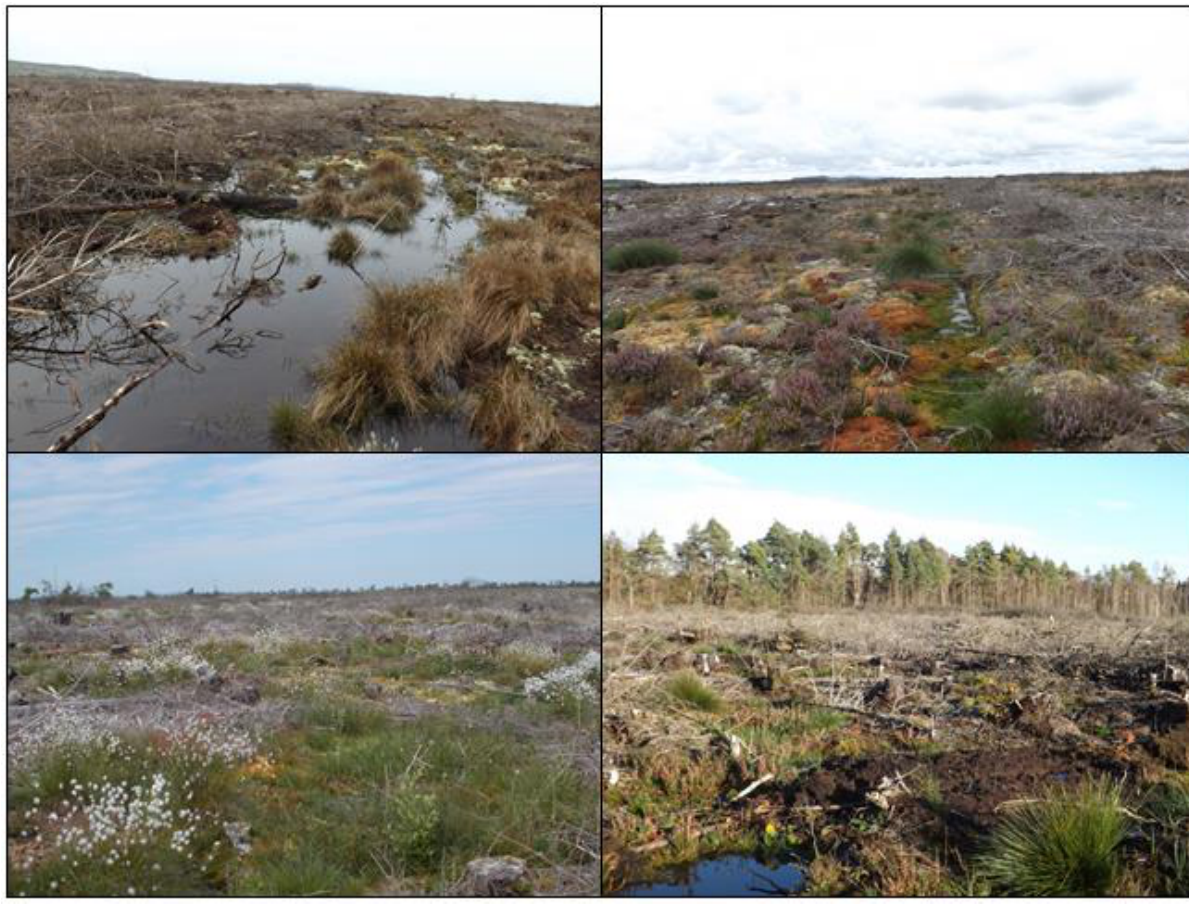
Figure 2. The Scohaboy site at different times during the two years of the study. Clockwise from top left: March 2014, August 2014, November 2015 and June 2015. Table 1. Plant species recorded in the study plots, listed in descending order of dominance at the end of